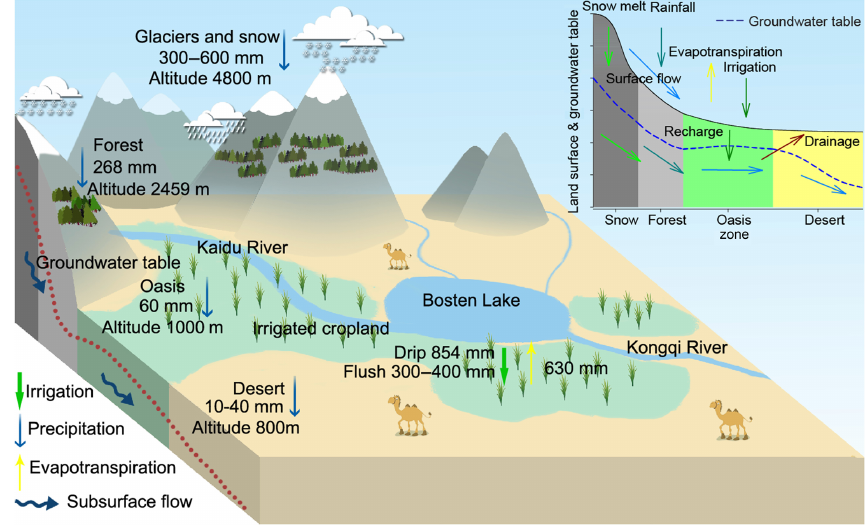
Figure 10. Regional process hydrology: schematic of the regional hydrologic cycle and waterscape in the Kaidu–Kongqi River basin, part of the much larger Tarim River basin, Xingjiang Province, in western China (taken from Zhang et al.,